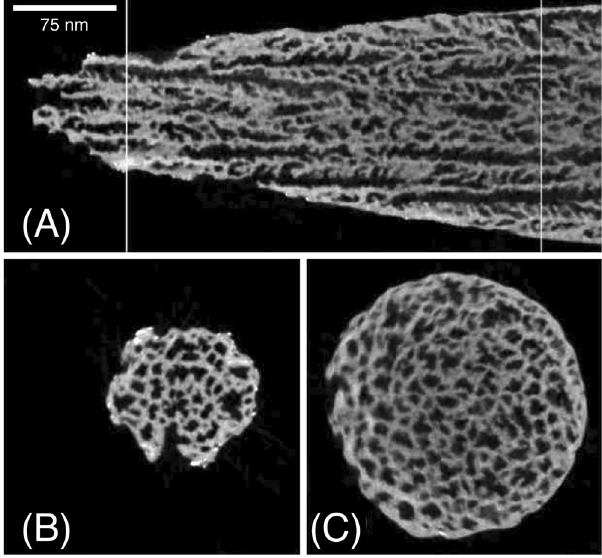
Figure 3. Needle-ET of the PSi_0 sample (pristine PSi sample). ( A ): sagittal sections extracted from the middle of the 3D reconstructed volume of the PSi needle, ( B – C ) axial sections extracted in correspondence of the white lines reported in panel